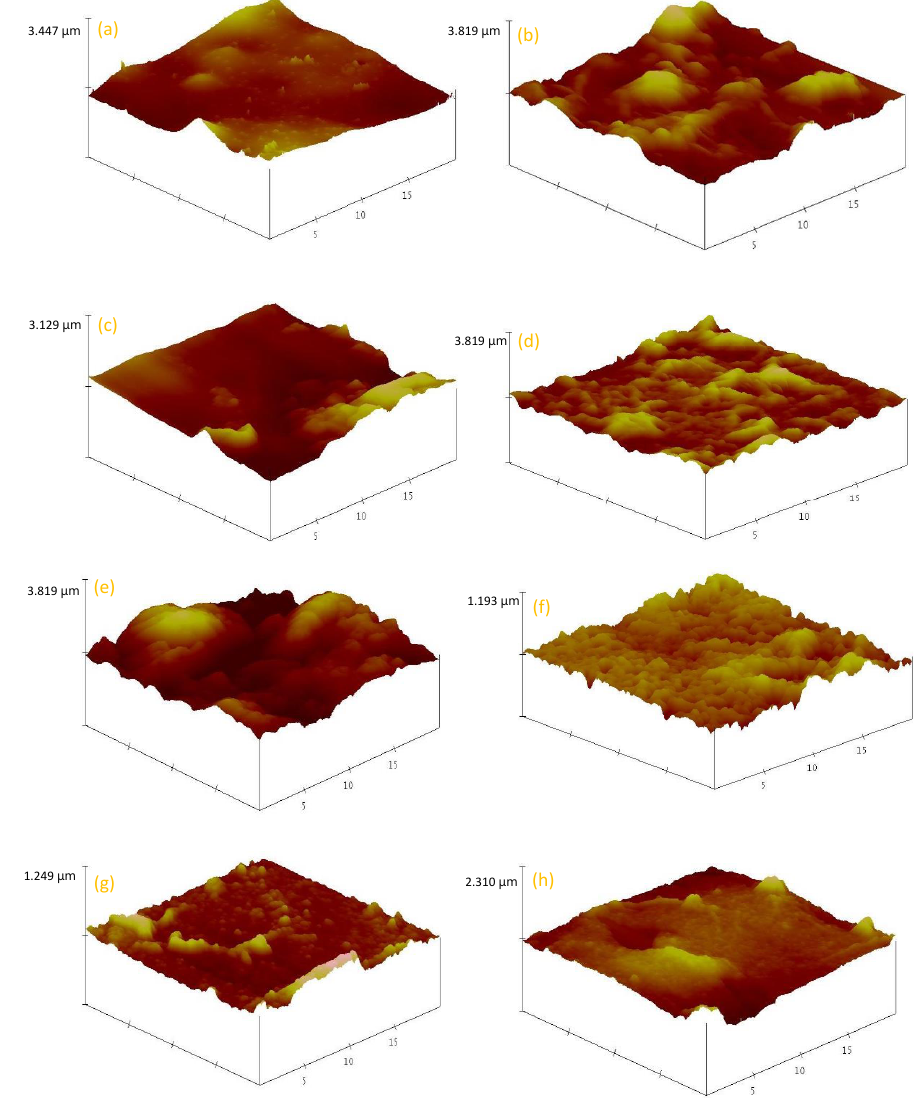
Figure 11. AFM analysis of ( a ) M0, ( b ) M1, ( c ) M2, ( d ) M3, ( e ) M4, ( f ) M5, ( g ) M6, and ( h ) M7. Table 5. Surface roughness parameters of M0–M7 and pure water